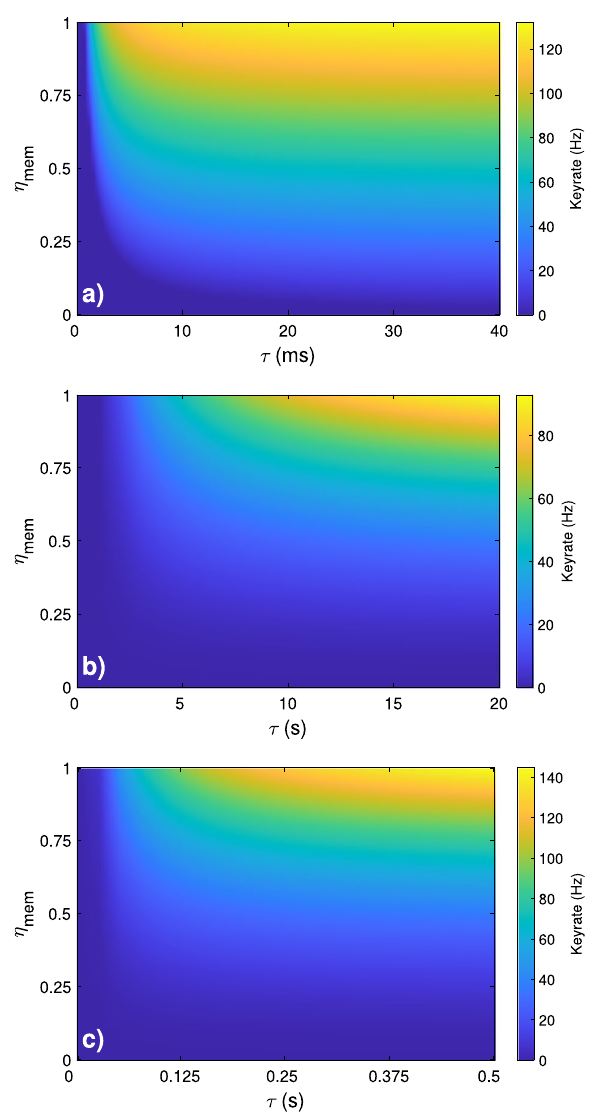
Fig. 5 Achievable key rates at 1000 km ground distance. a Uplink con fi guration with m = 1. b Downlink con fi guration with m = 1, N = 1000. c Downlink con fi guration with m = 100, N = 1000.